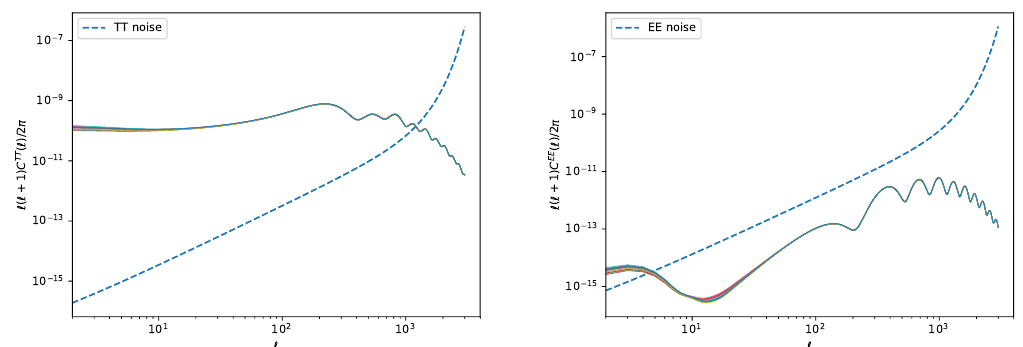
Figure 2: Angular power spectra for the TT (left) and EE (right) correlations for representative samples of the slow-roll parameters along with respective noise power spectrum.